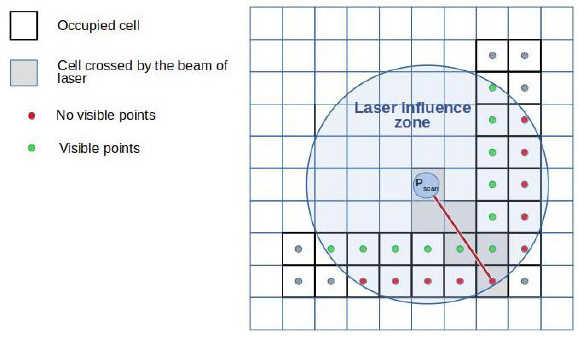
Figure 5. The principle of the ray-tracing